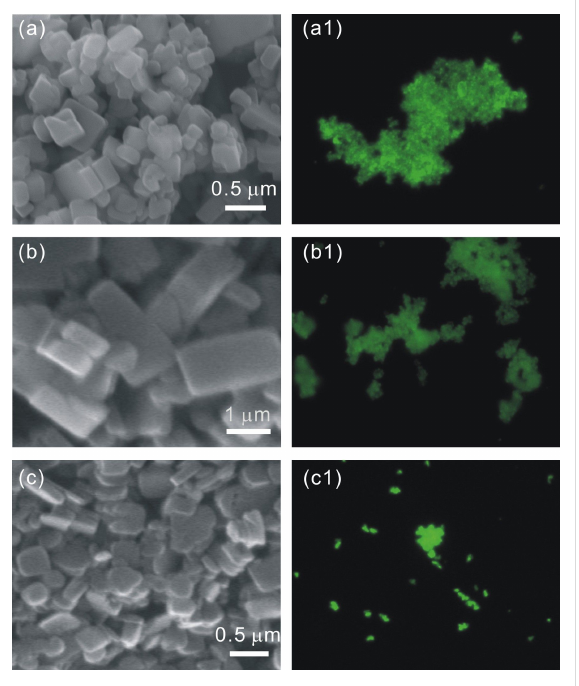
Figure 2: SEM images (a–c) and epifluorescence images (a1–c1) of Zn-MOF nanocrystals synthesized at various concentrations and ratios of the precursors at room temperature. (a) 50 mM of Zn–adc and 50 mM of dabco; (b) 50 mM of Zn–adc and 25 mM of dabco; (c) 25 mM of Zn–adc and 12.5 mM of